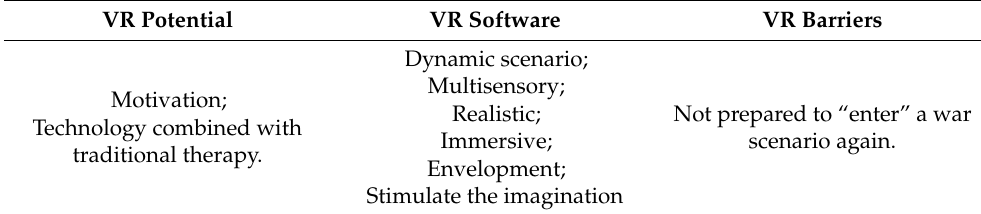
Table 3. Results of Study 2—Focus